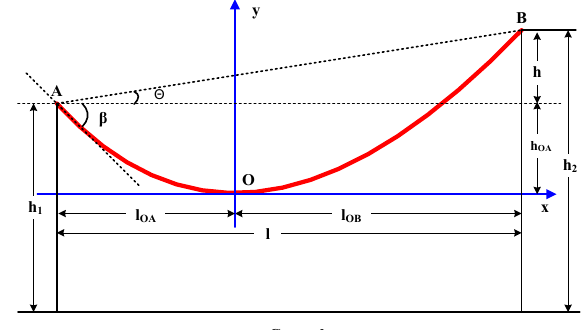
Figure 1 . The diagrammatic sketch of oblique